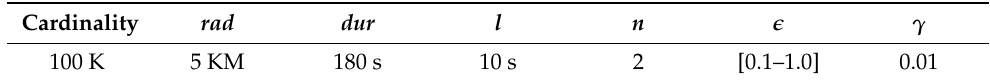
Table 6. Setting of synthetic data parameters and algorithm parameters in exploration rate experi- ment.